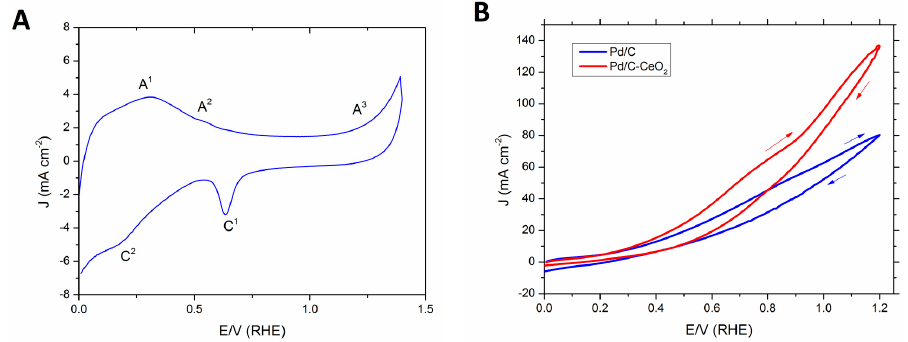
Figure 1. ( A ) Typical CV of Pd/C-CeO 2 in N 2 saturated 2 M KOH (scan rate: 10 mV·s − 1 ) and ( B ) Comparison of CVs obtained at room temperature of Pd/C-CeO 2 and Pd/C in N 2 saturated 2 M HCOOK + 0.5 M KOH (scan rate: 10 mV·s − 1 ).